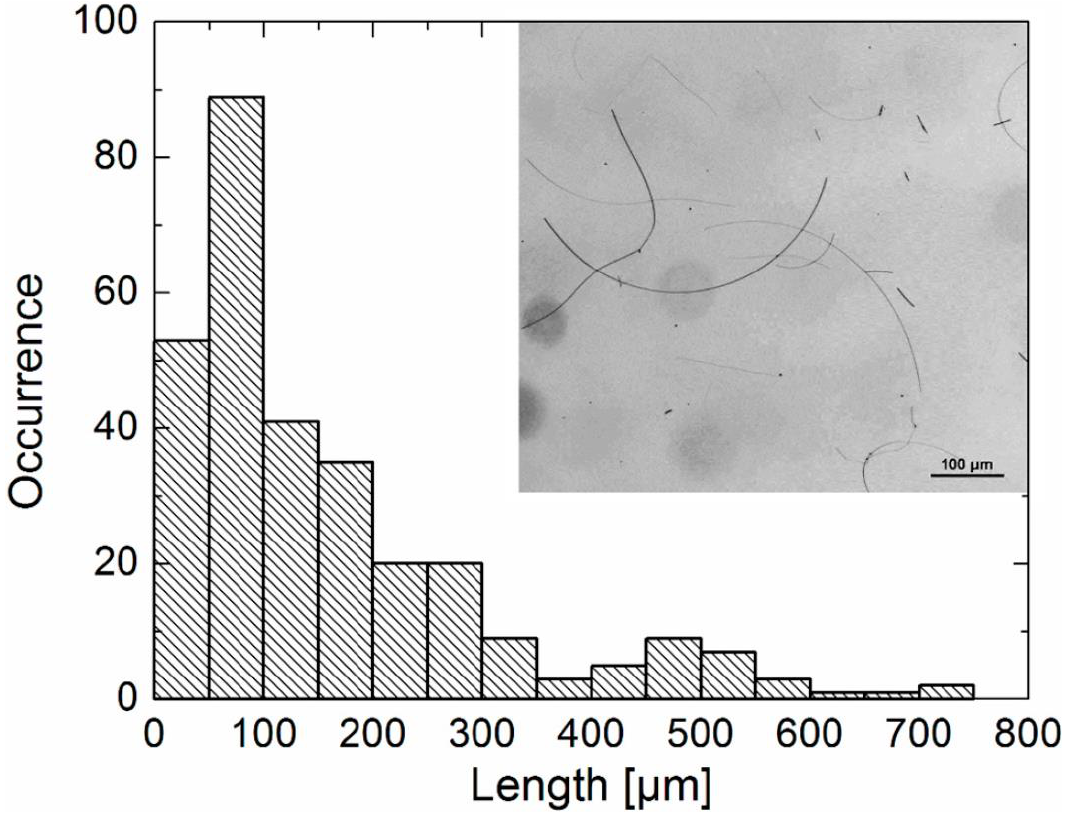
Figure 5. Length Distribution of AgNWs after the synthesis. An example of the reflection bright-field image is inset [61].